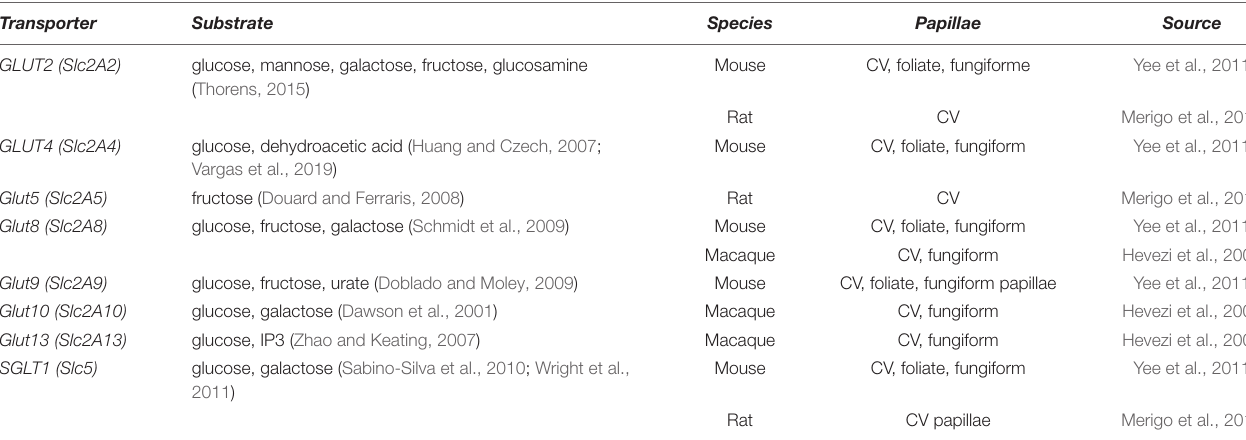
TABLE 4 | GLUTs and SGLT expression in taste bud